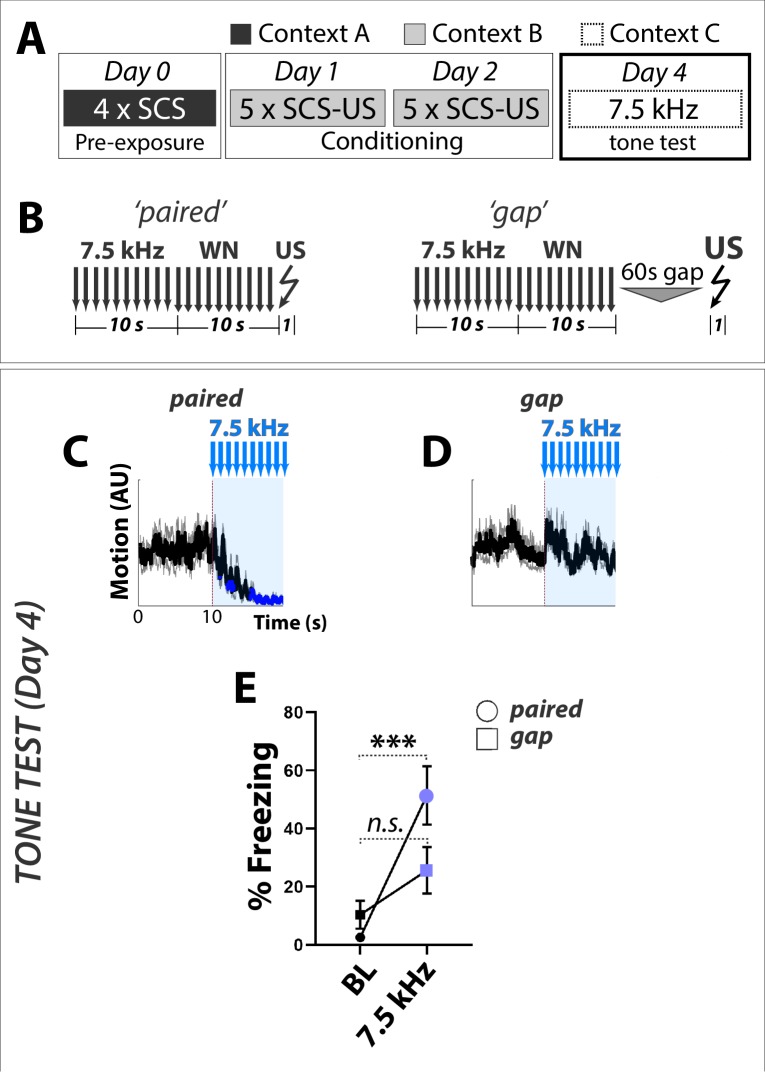
Mice trained in a paired SCS protocol acutely freeze to tone presentation in a novel context, demonstrating Pavlovian Conditioning.(A,B) Protocol and structure of stimuli applied during conditioning. (C,D) Motion indices (mean ± SEM) in a novel context tone test for mice trained on a paired (C, n = 8) or gap (D, n = 7) SCS conditioning protocol, showing a single 10 s presentation of 7.5 kHz tone pips; onset of tone stimuli is indicated by light blue shading. Blue segments of the motion trace indicate statistically-significant decreases from the baseline (p<0.05; multivariate permutation tests). (E) Paired but not gap trained mice show significantly increased freezing in response to 7.5 kHz tone presentations. Error bars indicate SEM.Figure 1—figure supplement 1—source data 1.Raw data used to generate motion traces and freezing graph.Figure 1—figure supplement 1—source data 2.All statistical tests and significant comparisons with F and P values.